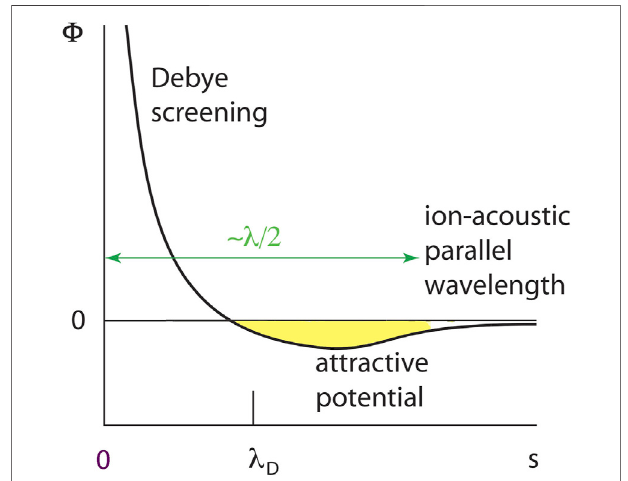
FIGURE 2 | Debye and attractive potentials. The parallel ion-acoustic wavelength covers the attractive potential for resonant electrons.